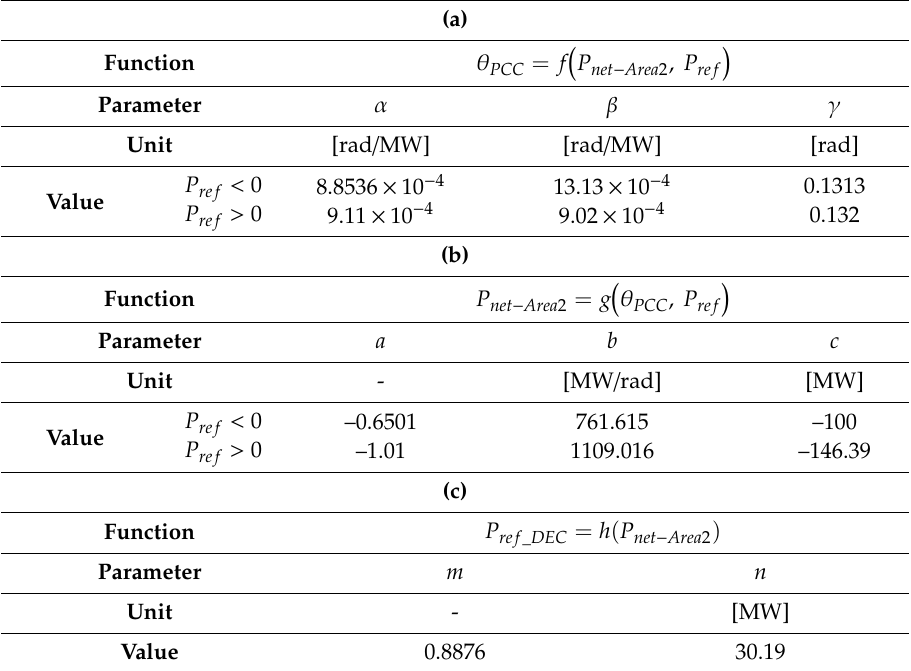
Table 1. Parameters of response curves.